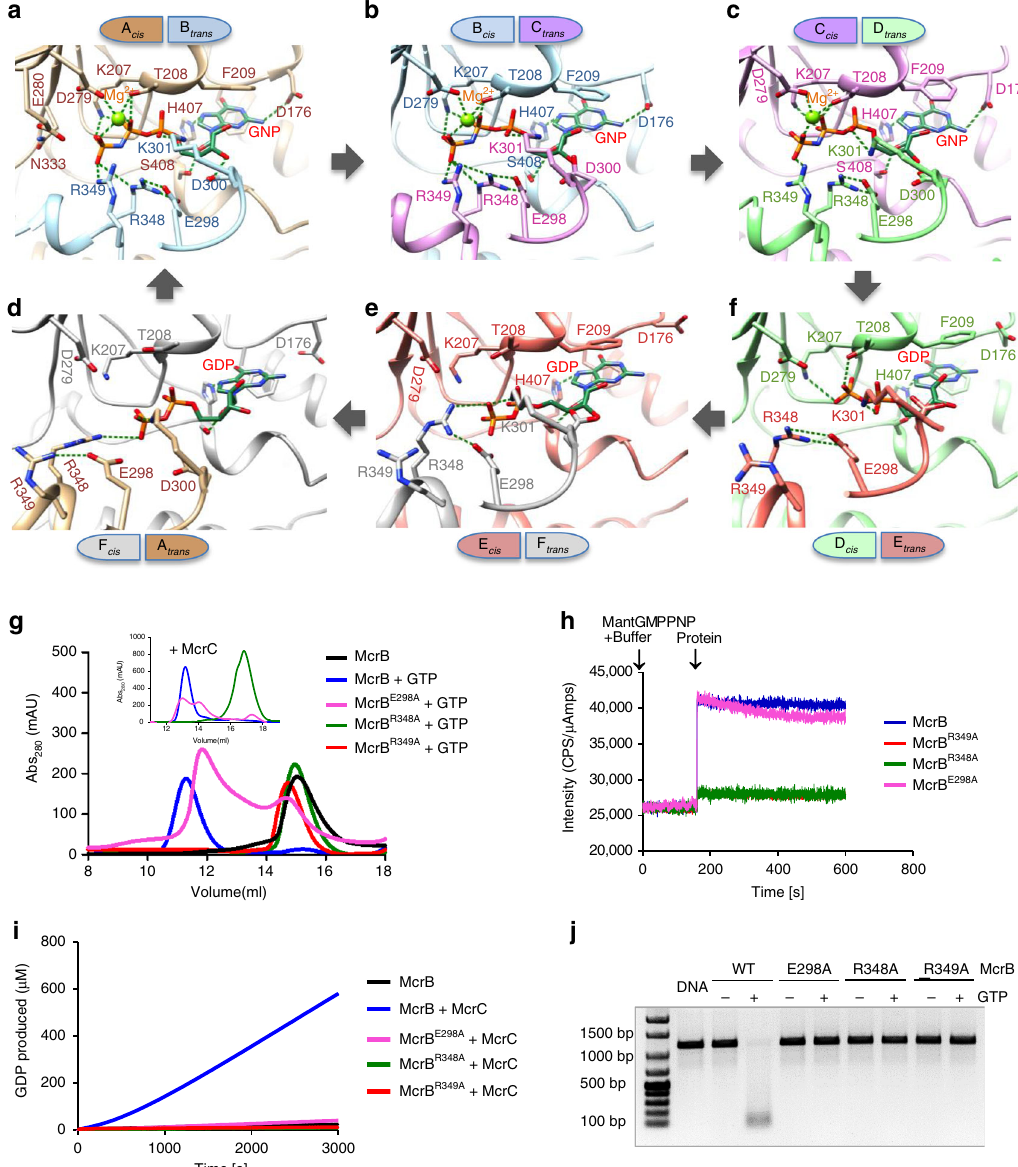
Fig. 2 Nucleotide binding at the McrB Δ N interfaces. a – f Six panels, arranged in a clockwise cyclic manner, illustrating the interactions made with the nucleotide at the six interfaces. Green dotted lines represent potential hydrogen bonds (<3.6 Å) and ionic interactions (<4 Å). g Size exclusion chromatographic pro fi le of McrB and its mutants in the presence of GTP using Superdex 200 column and in the presence of McrC and GTP using Superose 6 column (inset). h Comparison of GNP binding by McrB and its mutants. The binding curves of McrB R348A and McrB R349A overlapped. i Comparison of the GTPase activity of McrB and its mutants in the presence of McrC. j Nucleolytic activity of McrB and its mutants in the presence of